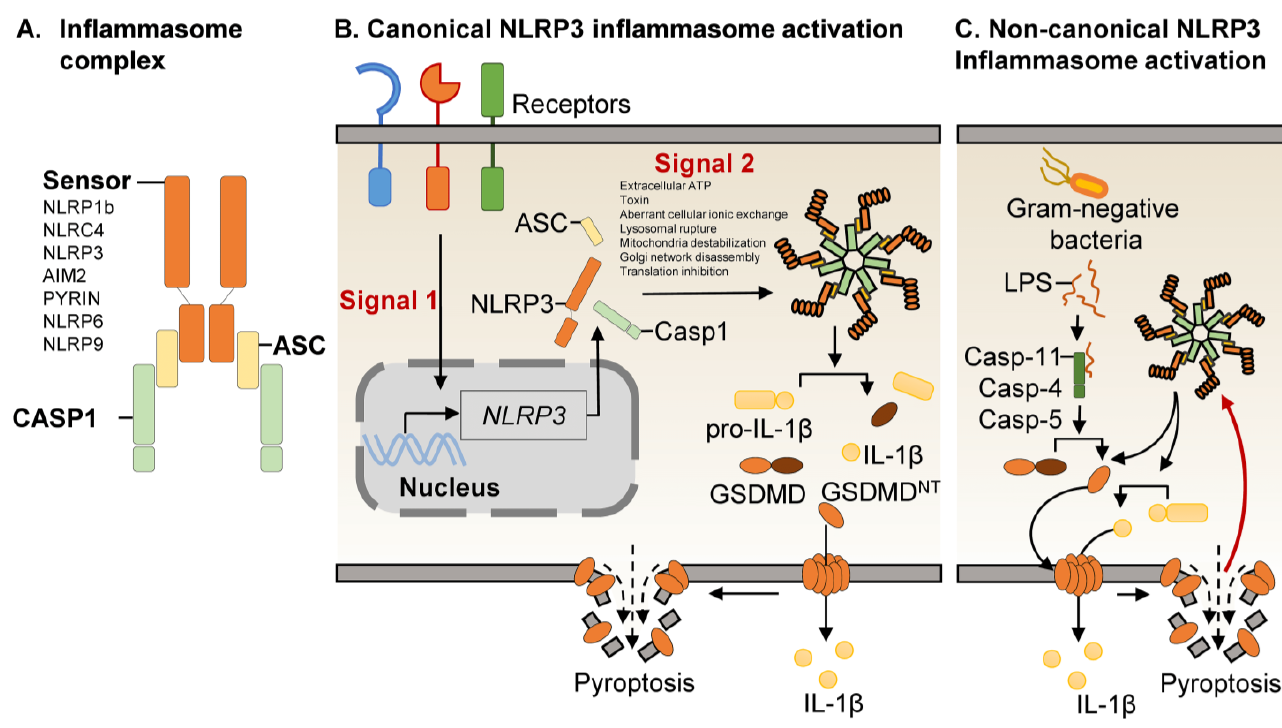
Figure 1. NLRP3 inflammasome assembly. ( A ). Inflammasome complex . Inflammasomes are com- posed of cytosolic sensors, which trigger caspase-1 activation. The identified cytosolic sensors